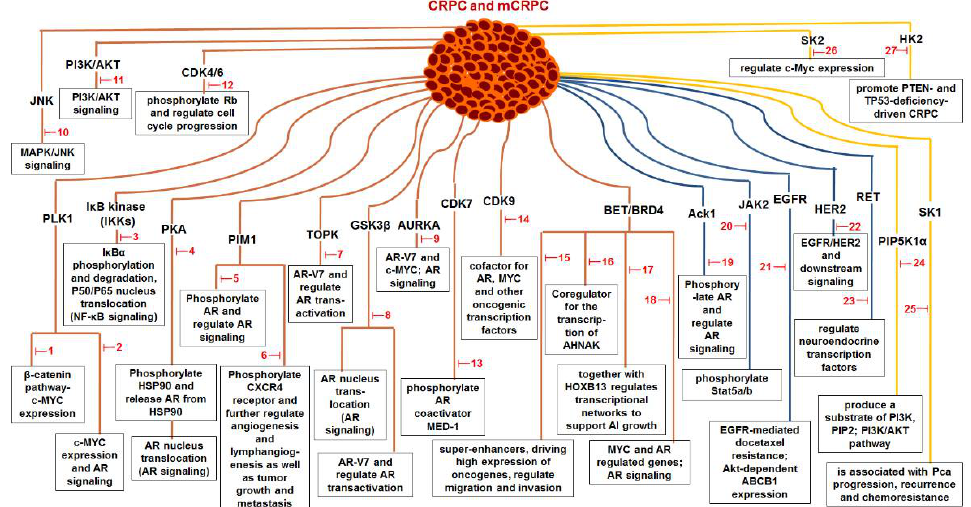
Figure 2. Therapeutic strategies that target key kinases in CRPC. Note: 1: combined GSK461364A